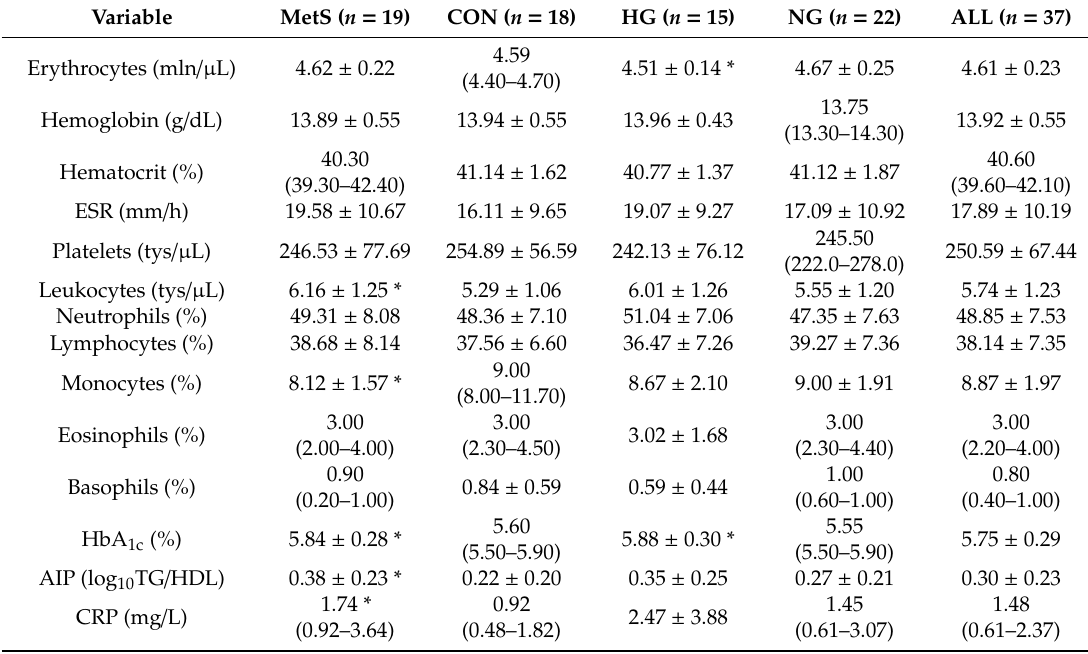
Table 3. Results of laboratory blood analysis in the groups under